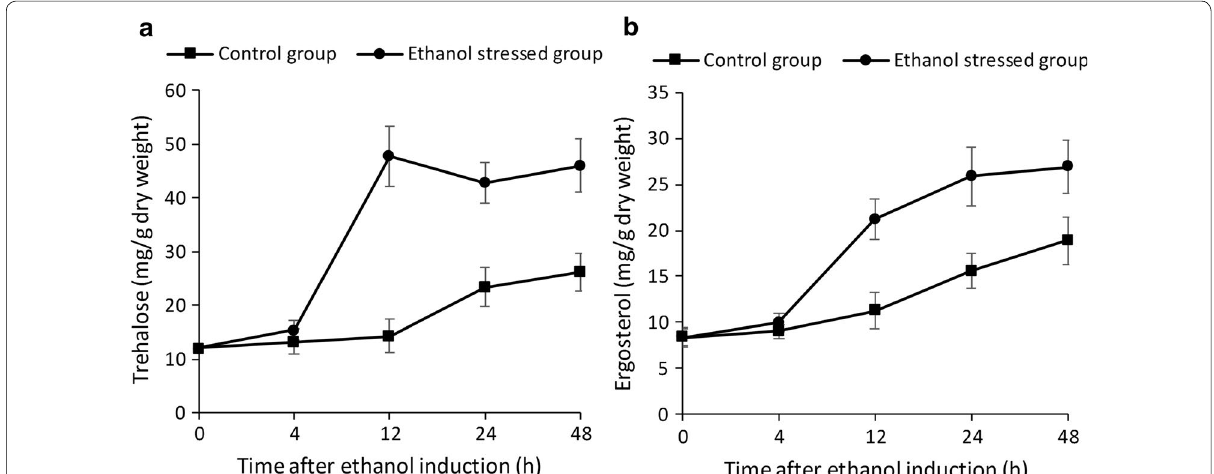
Fig. 1 Intracellular concentrations of trehalose and ergosterol in ethanol-stressed I. orientalis . The data were obtained at the indicated times (h) after ethanol was introduced into the culture. Values are represented as mean